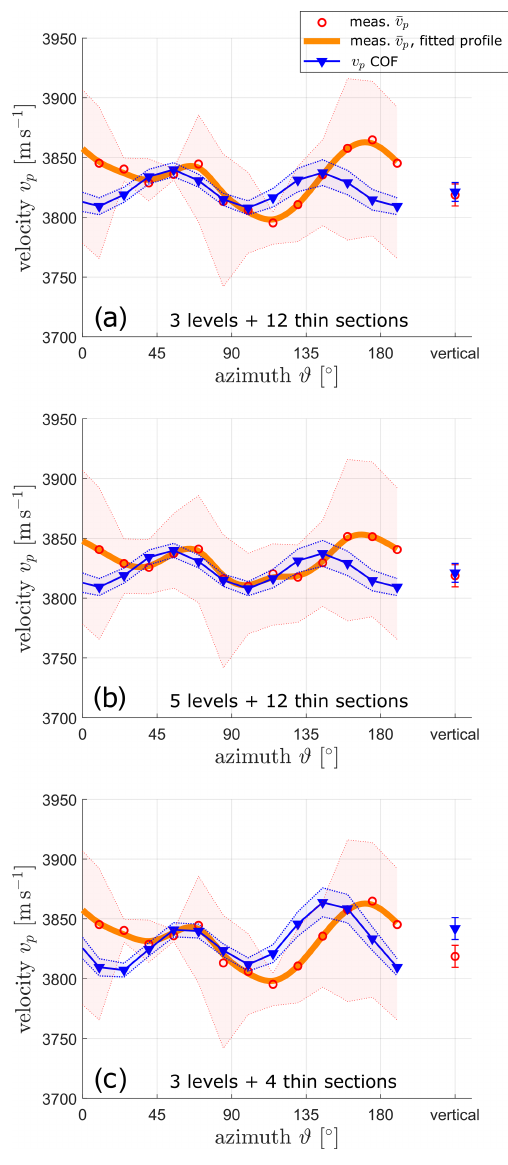
Figure 7. Mean measured seismic velocities from ultrasonic experi- ments (orange curve and red dots) and the corresponding calculated velocities from the COF distribution (blue curve) for the sample at 33m: (a) same as Fig. 4c, (b) with a larger amount of ultrasonic measurements, and (c) with a smaller amount of thin sections con- sidered for the calculated COF-derived velocity